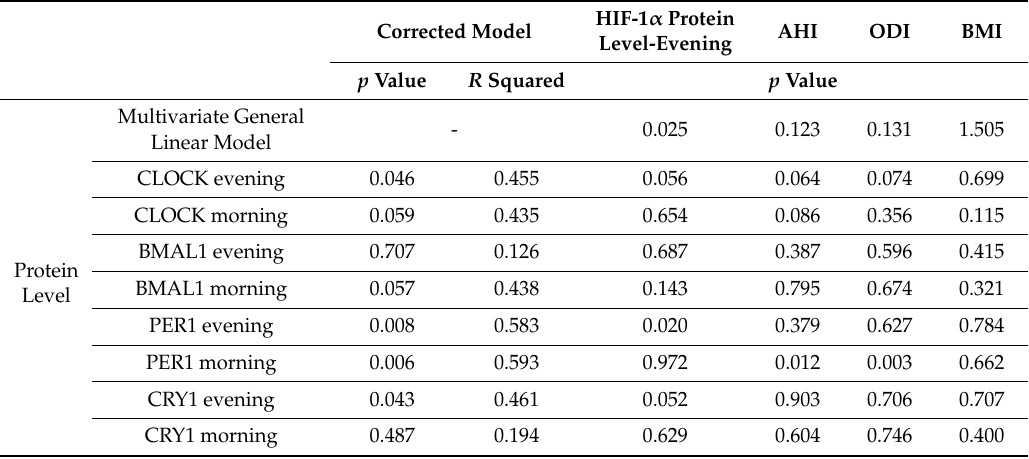
Table 2. Multivariate general linear model of circadian clock